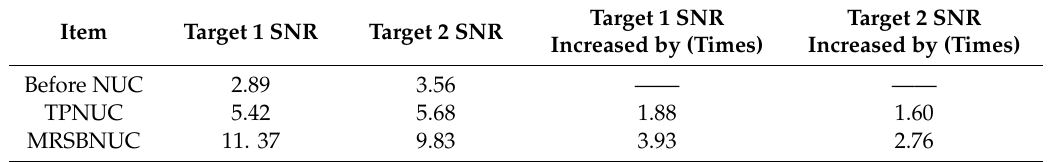
Table 4. SNR before NUC, after TPNUC and MRSBNUC for Target 1 and Target